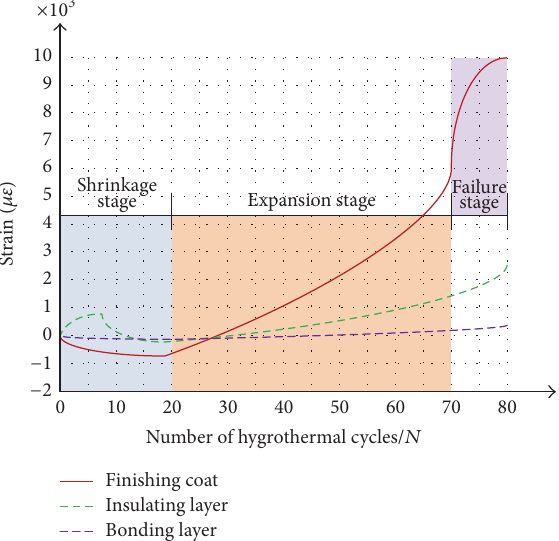
Figure 14: Accumulating process of fatigue